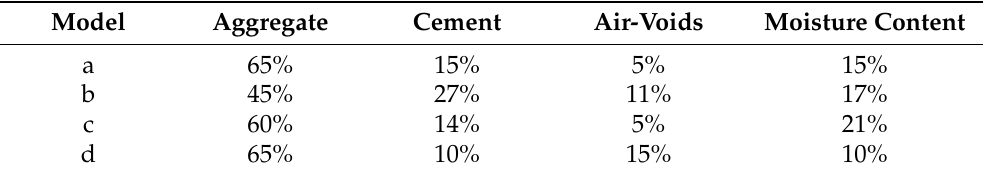
Table 2. The volumetric fraction of the concrete’s components of the models shown in Figure 4. Some of these percentages are not within the ranges shown in table 1 in order to illustrate the modelling capabilities of the current framework for extreme